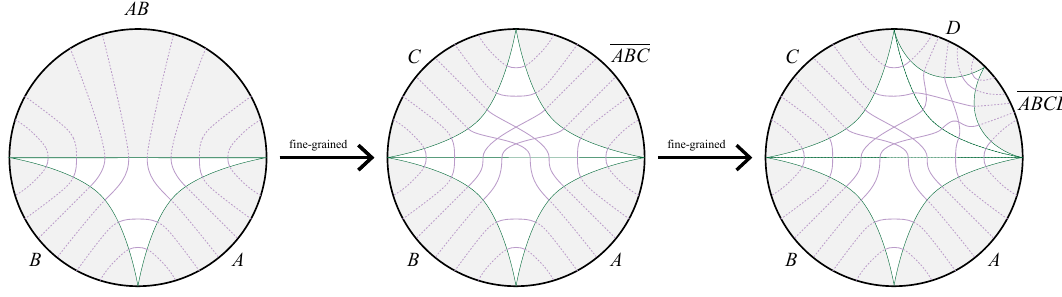
Figure 7 . Given an initial bit thread configuration V locking three regions { A, B, AB } simultane- ously, by further decomposing a two-sided cell (grey region) into a three-sided cell (white region) and two smaller two-sided cells, one can use the replacing method to construct a new fine-grained thread configuration. This refinement process can be repeated iteratively. This “replacement” description is equivalent to the bulk cell gluing method in section